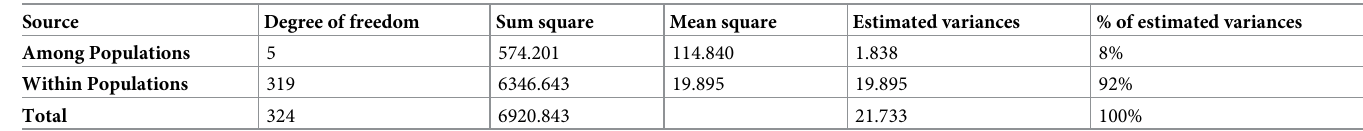
Table 5. Analysis of molecular variance of all loci for the IC population in Rwanda.